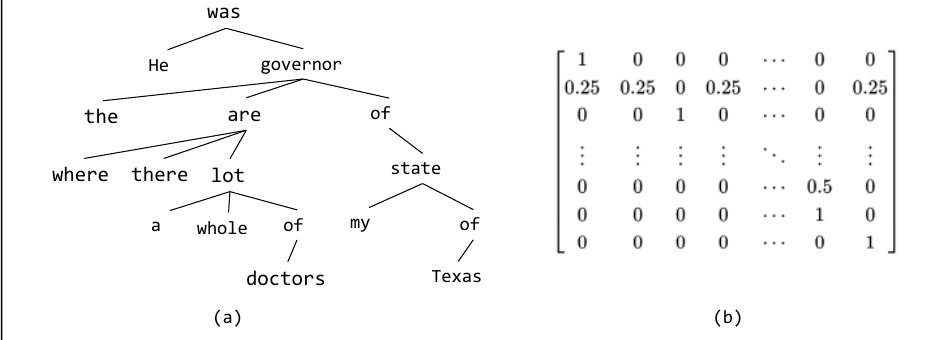
Figure 2. Syntactic dependency tree and corresponding adjacency matrix, as generated for a given context. ( a ) Shows the syntactic dependency tree and ( b ) shows the corresponding normalized adjacency matrix of the syntactic dependency